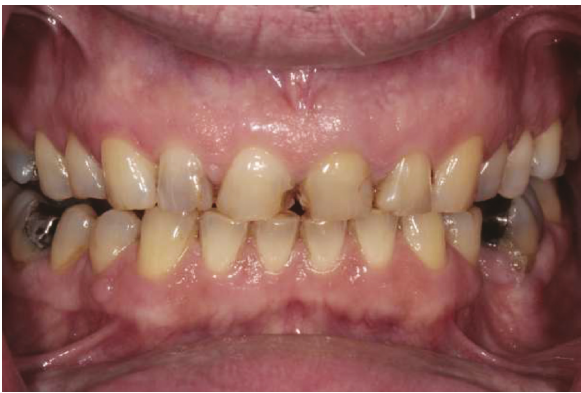
Figure 2: Intraoral frontal view.